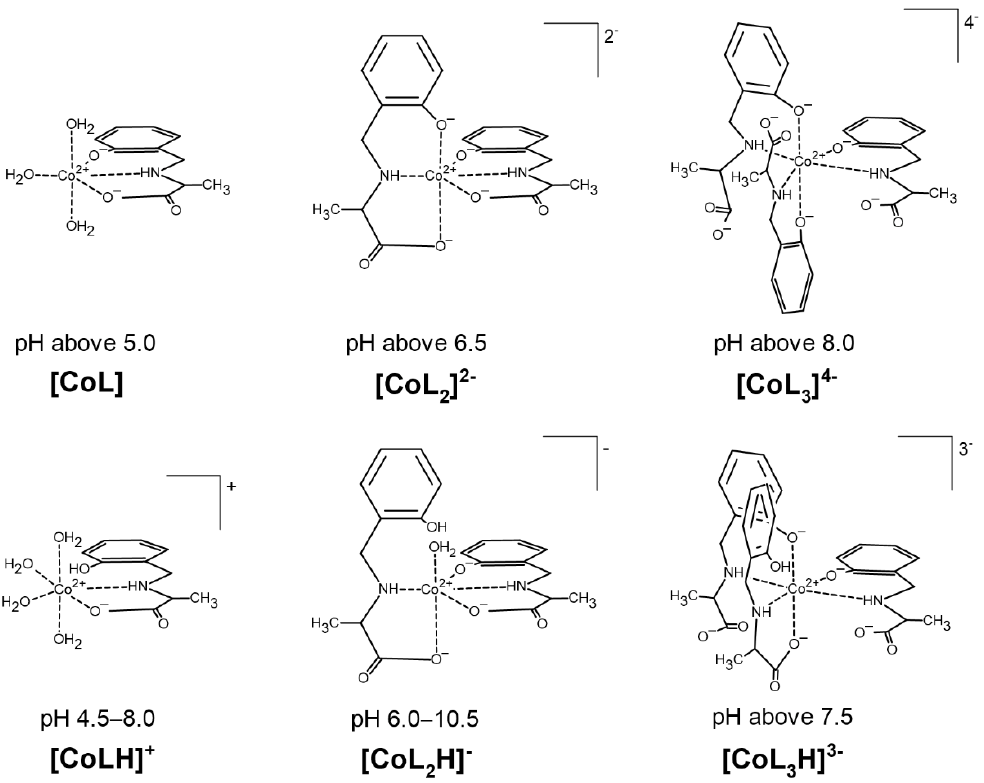
Figure 2. Suggested coordination modes of the complexes in the Co(II)–AlaSal system in dependence on the pH.